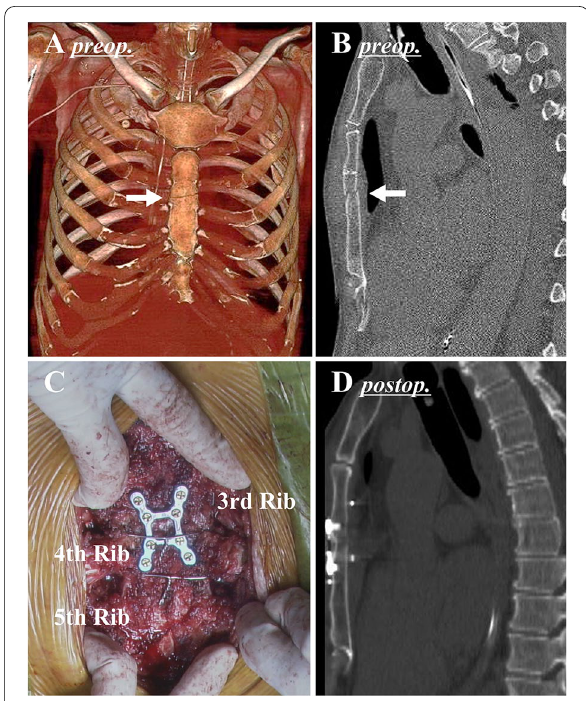
Fig. 3 Preoperative image and intraoperative photo in Case 2. A , B Preoperative computed tomography demonstrated that a fracture line was found at the 3rd intercostal level (arrow) and the posterior displacement of the lower sternum. C The sternum was reduced with a combination of modified Robicsek wire fixation and plate fixation using an 8-pin H-shaped SternaLock ® plate. D Postoperative computed tomography confirmed that the sternum was properly